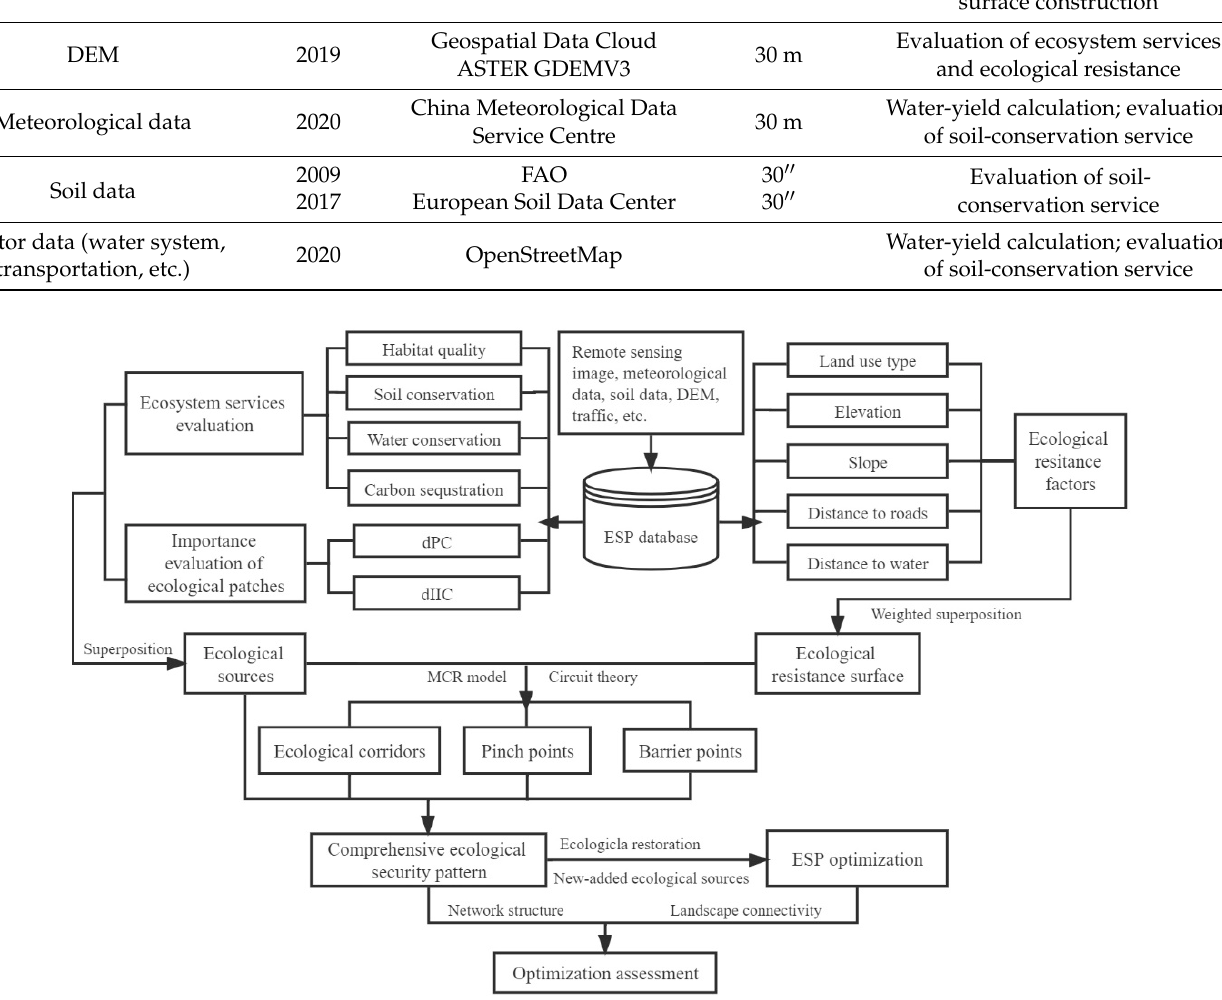
Figure 3. The research flow chart.